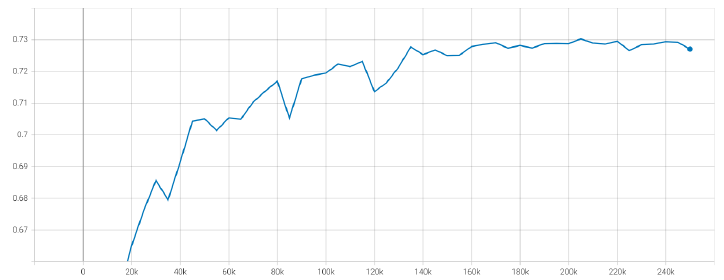
Figure 8. The average CCC curve on validation dataset.